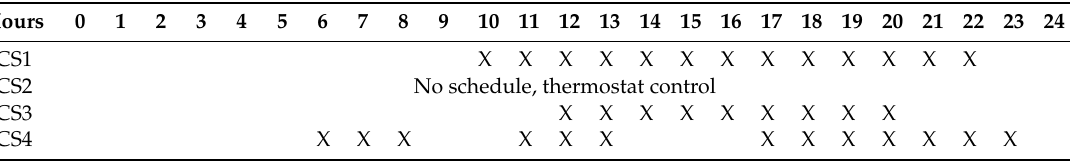
Table 6. Operating hours of the heating systems of the case